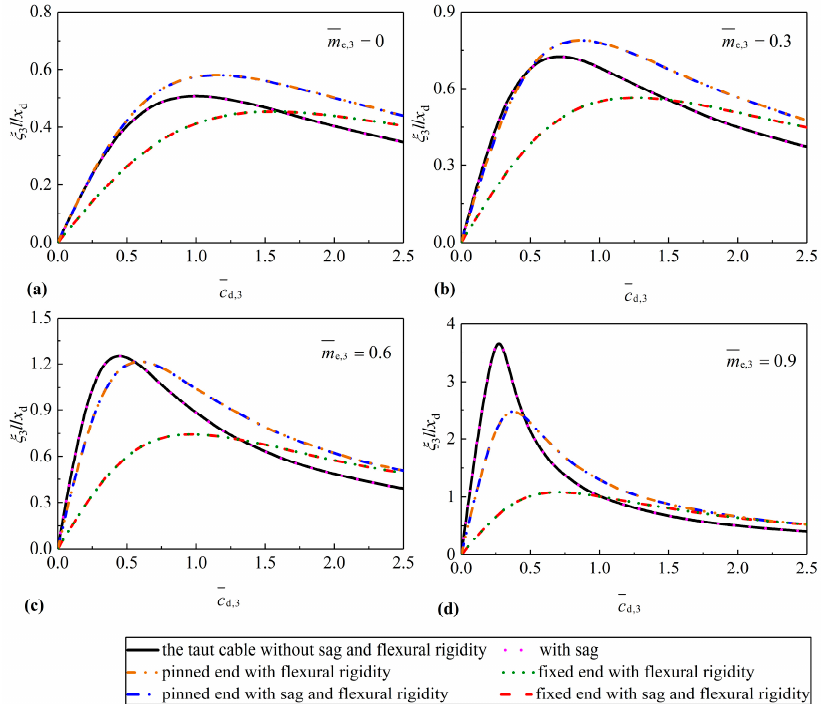
Figure 10. The third supplemental modal damping ratio of the medium cable versus damping coefficient for various inertial masses: ( a ) m e,3 = 0; ( b ) m e,3 = 0.3; ( c ) m e,3 = 0.6; ( d ) m e,3 =